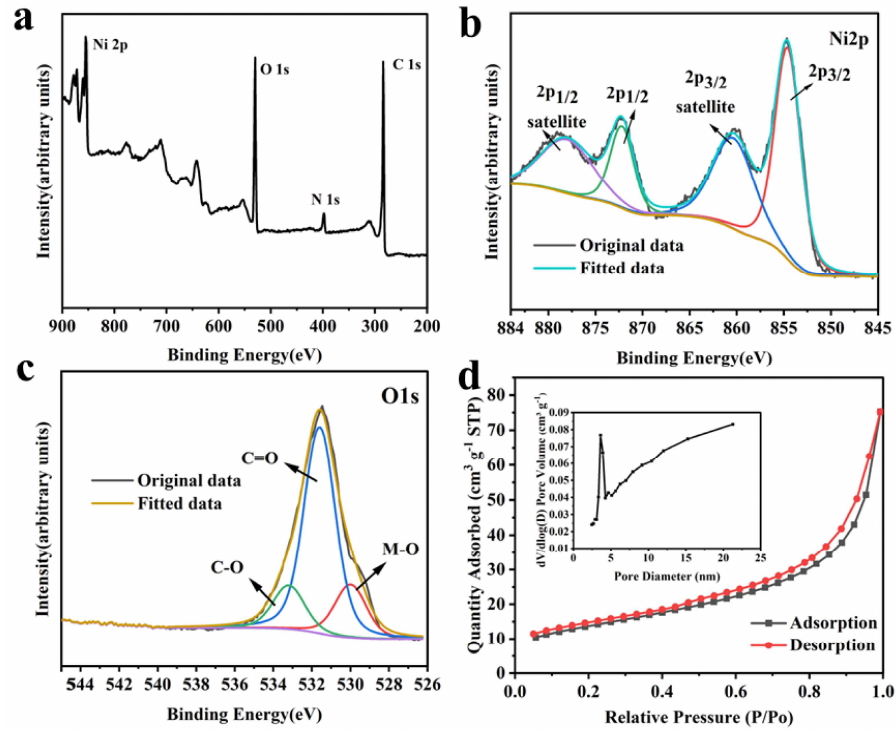
Figure 5. Survey ( a ), Ni2p ( b ), O1s ( c ) XPS spectra, and N 2 adsorption-desorption isotherm as well as pore size distribution (inset) ( d ) of CNFs@Ni(OH) 2 /NiO-250.